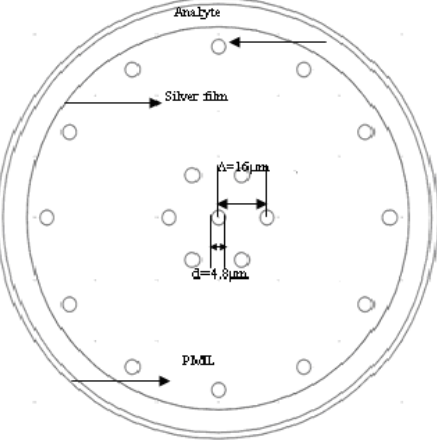
Figure 3. Structure diagram of the improved large-mode-area plastic PCF with 125 μ m diameter and seven air